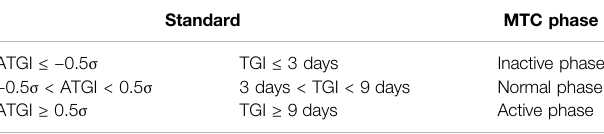
TABLE 1 | Classi fi cation of the MTC phases based on the standard deviation σ of the TC genesis interval (TGI) in the WNP (ATGI denotes the anomalous TC genesis